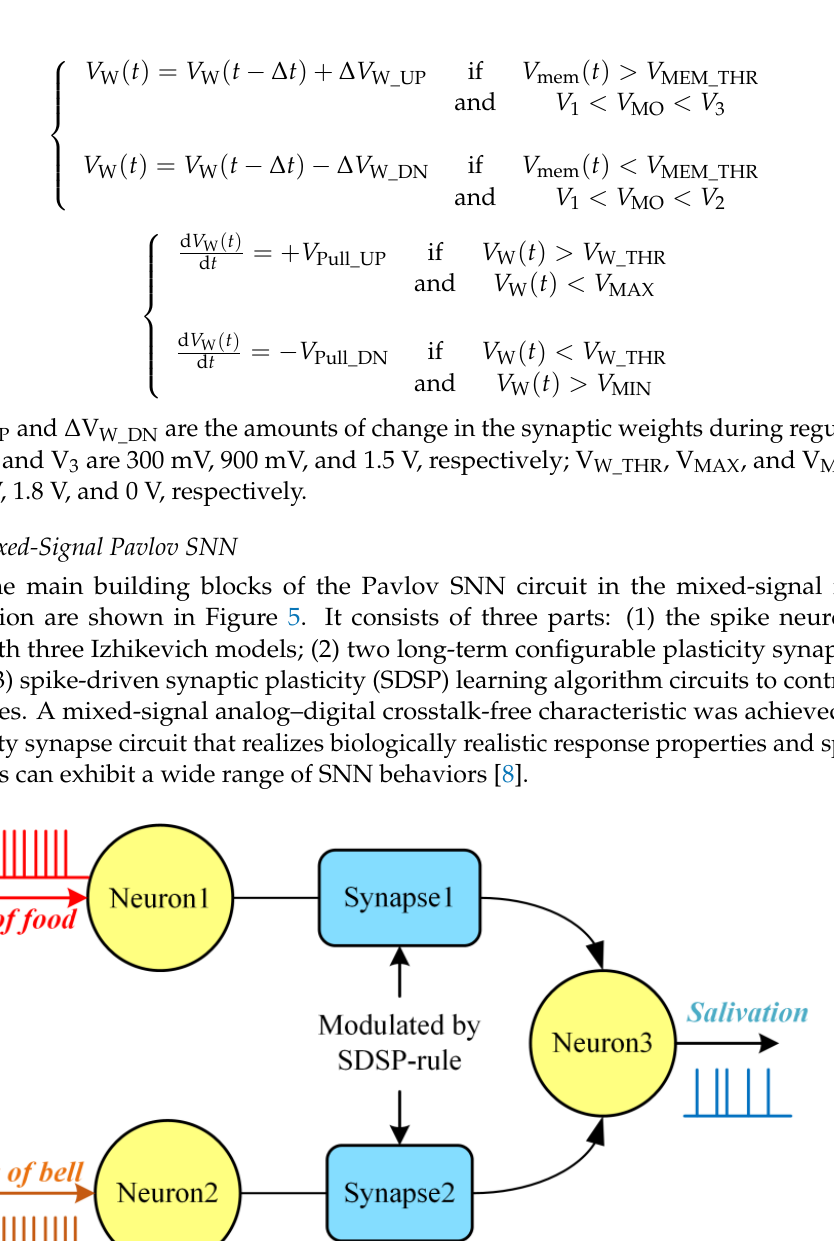
Figure 6. Pavlov SNN network simulation result. The simulation time is divided into five parts “A–E” in units of 50 microseconds